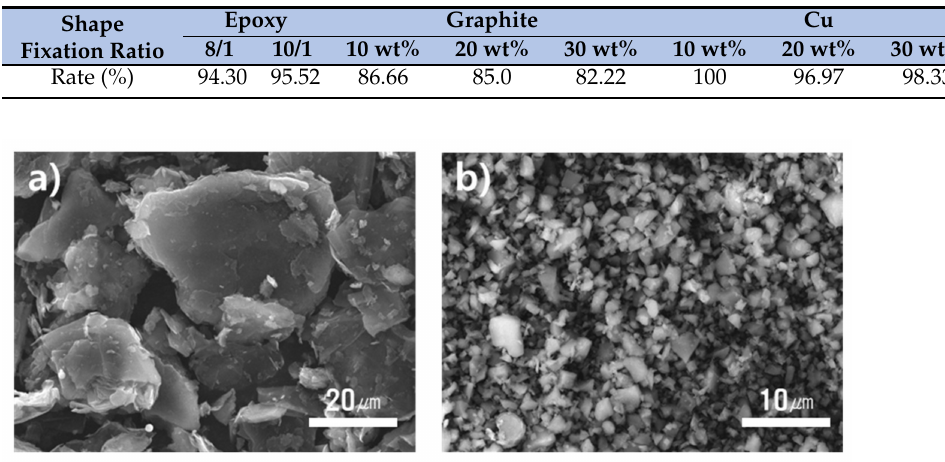
Figure 8. Comparison of the shape fixation ratio by amount and type of filler. Table 4. Shape fixation ratio.